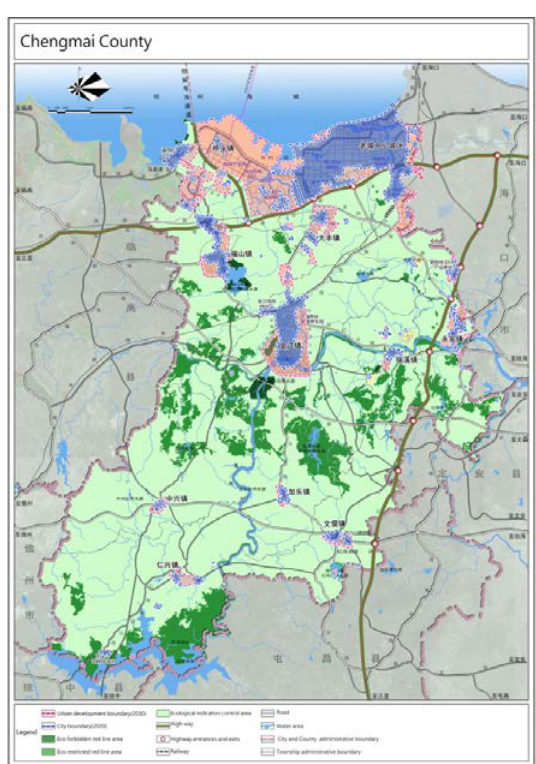
Table 7. Forecasted area and planning area